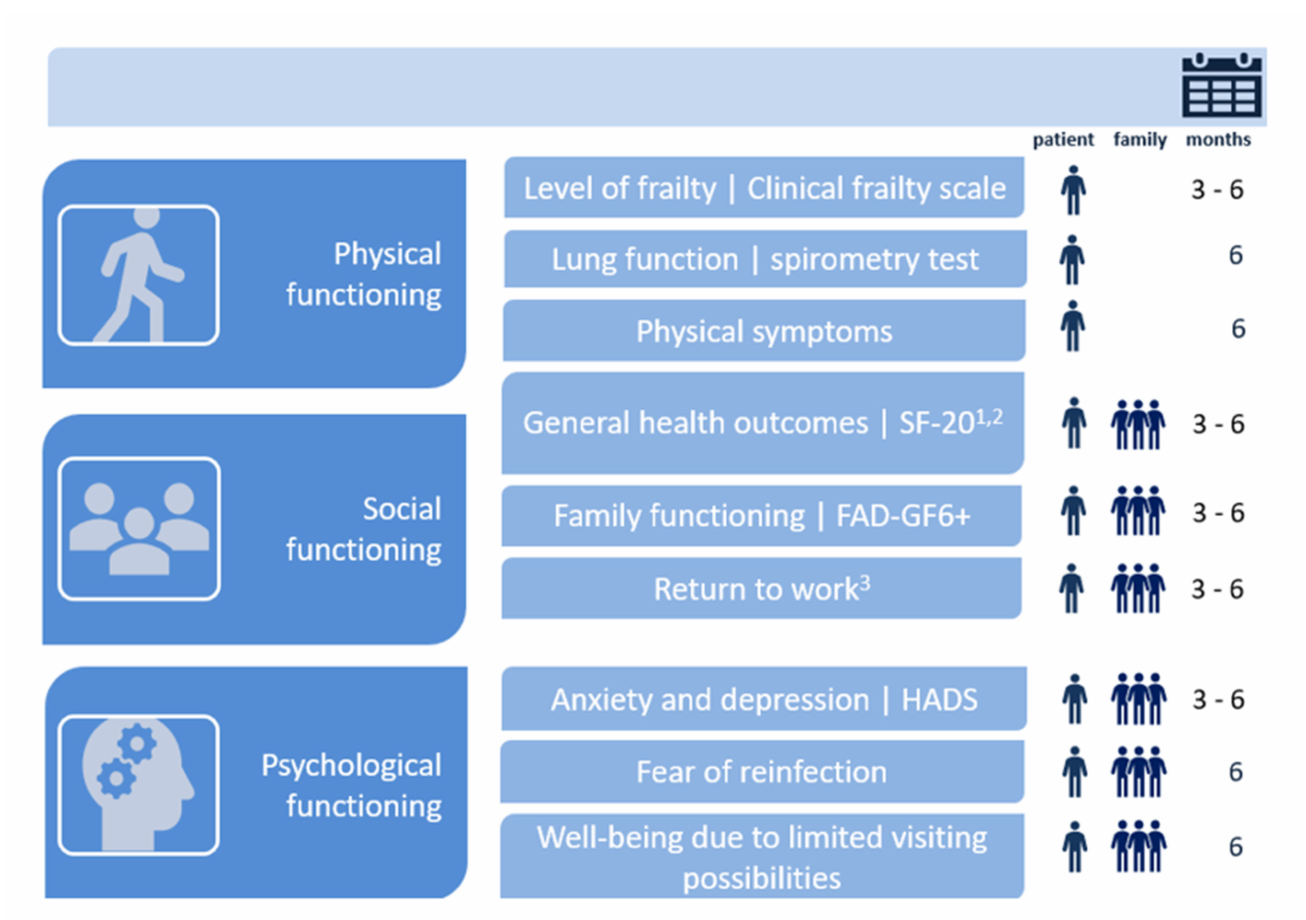
Figure 1. Overview of outcome variables per domain of the COFICS at three and six months post ICU discharge. 1 Subscale mental health is excluded. 2 Family members received these questions only at 3 months. 3 Patients received these questions only at 6